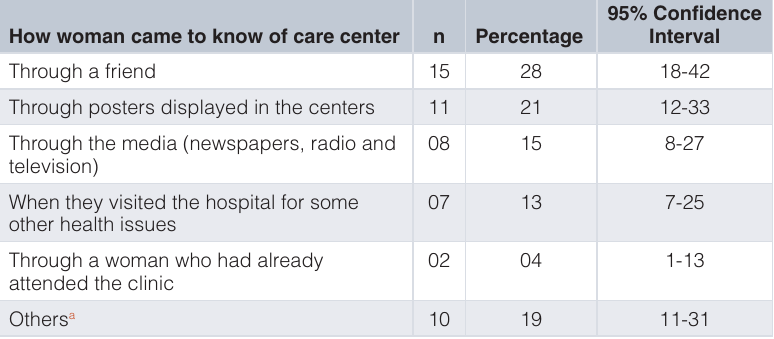
How woman came to know of care